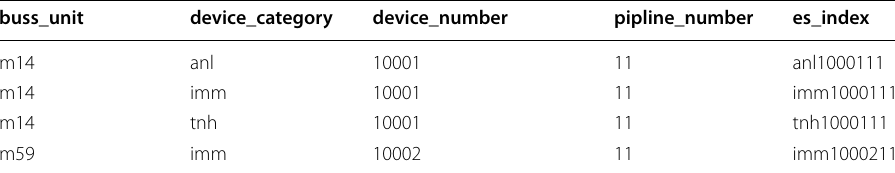
Table 1 Naming conventions and device data sample table captured from DataCone’s master